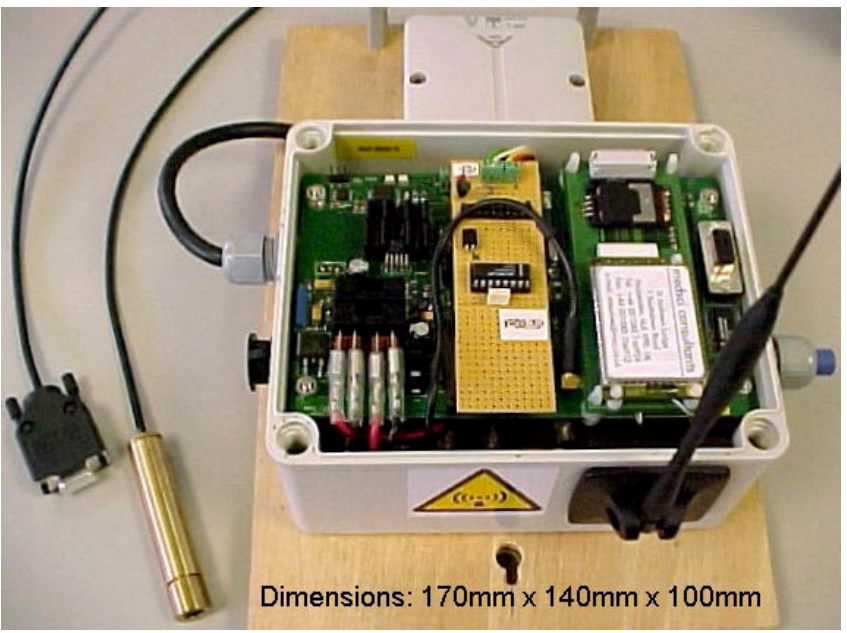
FIGURE 3. The field-based monitoring system consists of the data logging unit, to which n -sub-surface sensors may be connected via standard 9-pin sub-D